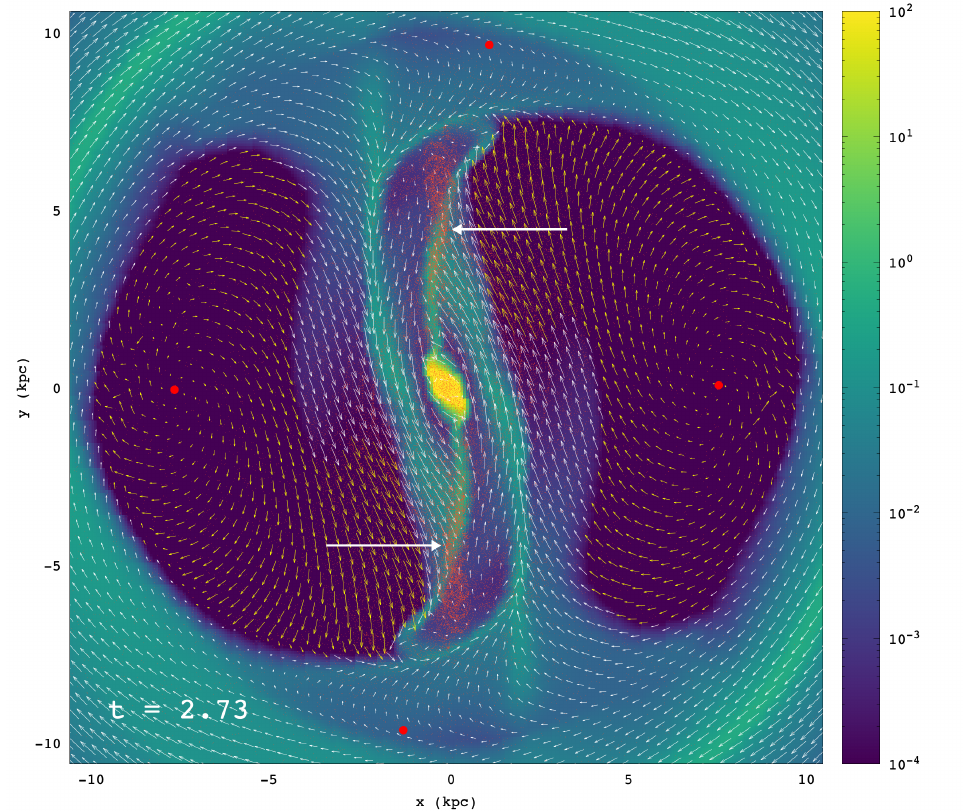
Figure 13. A typical snapshot of our RAMSES simulation, summarizing the main morphological features, together with the velocity vectors indicating the flow. The flow vectors are colored yellow, when they are in regions below the minimum density we considered. The two long white arrows indicate the point where the tails of the Γ features join the dust-lane shocks in the bar region. The stellar response is given in the background using a red color for the test